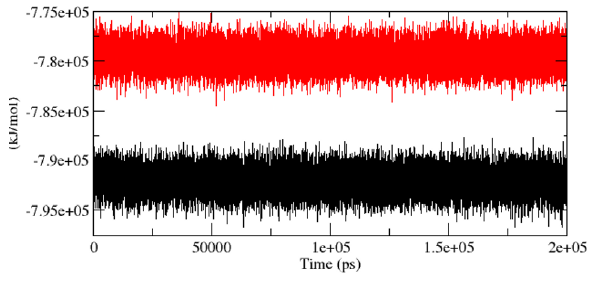
Figure 9. Graph of total energy as a function of time for mutant and native Aurora A protein versus time at 300 K. Mutant is shown in red and native in black.